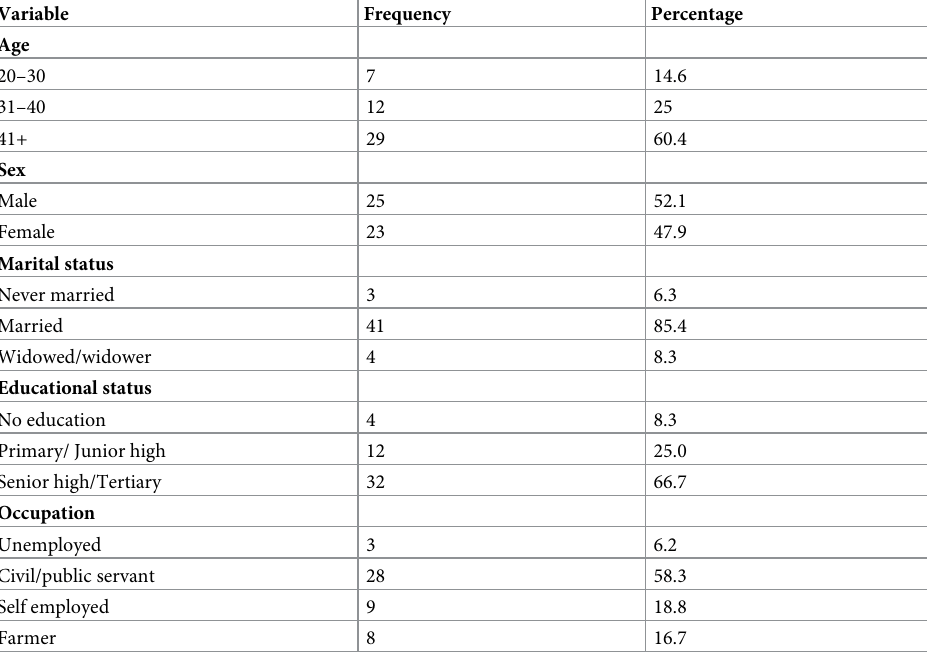
Table 1. Socio-demographic characteristics of